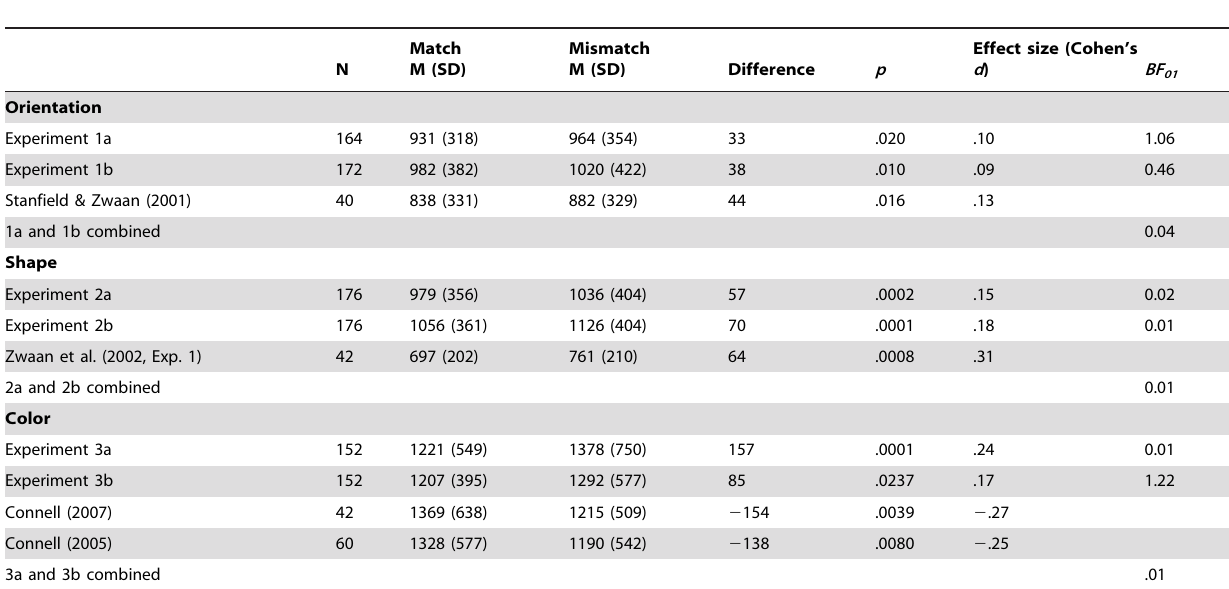
Table 1. Overview of Match Effects (Median RTs) in Experiments 1a to 3b and in Previous